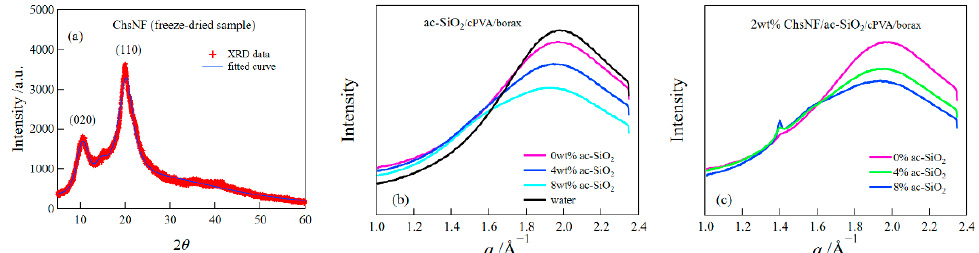
Figure 5. XRD curve for ChsNF powder ( a ), WAXS curves for ac-SiO 2/ cPVA/borax hydrogels ( b ), and ChsNF/ac-SiO 2 /cPVA/borax ( c ) hydrogels.